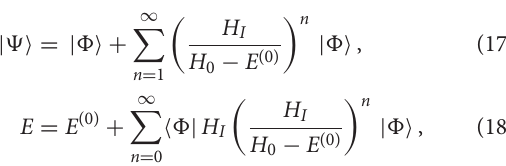
which is widely used for its convenience,